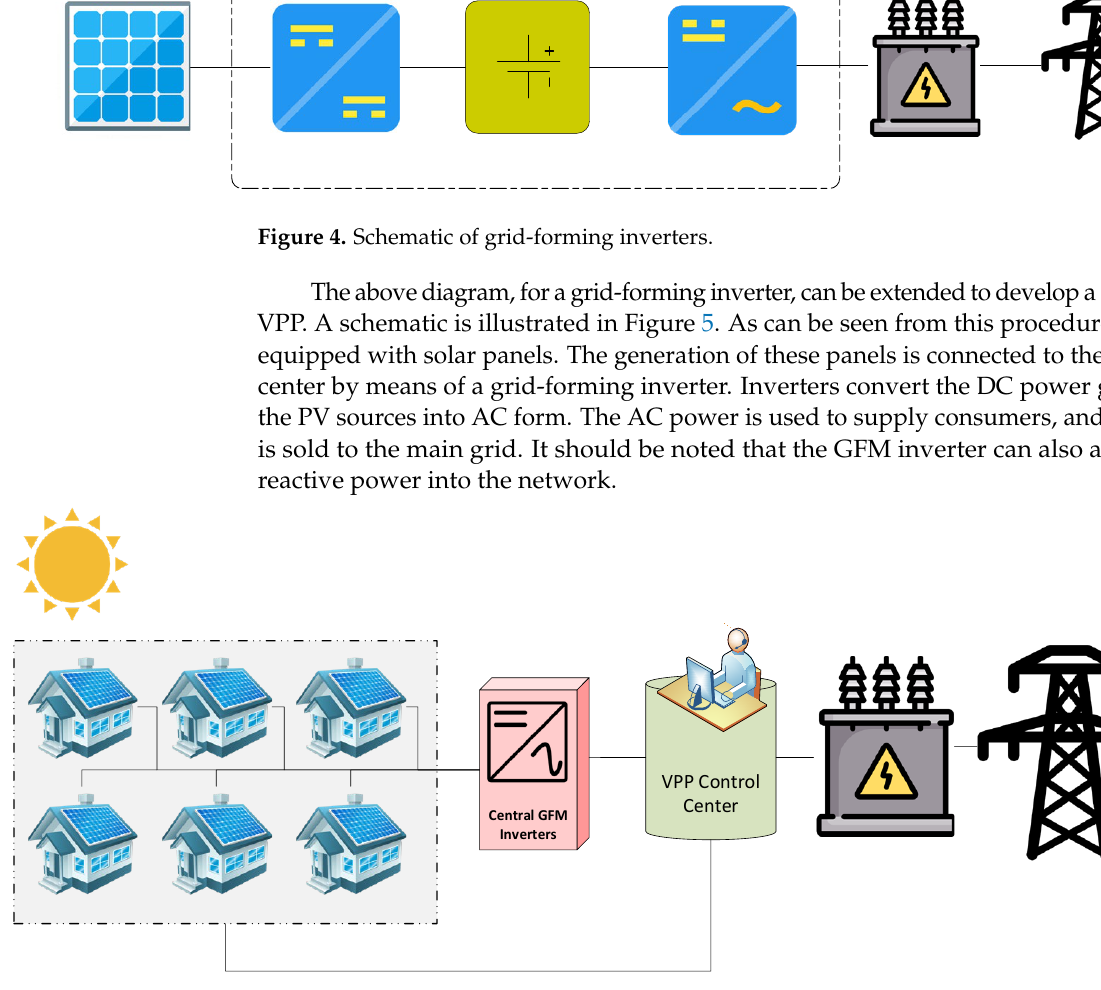
Figure 5. Schematic of a grid-forming VPP without energy storage.